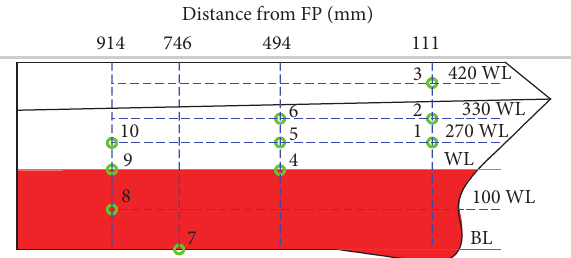
Figure 5: Pressure gauges arrangement at bow.